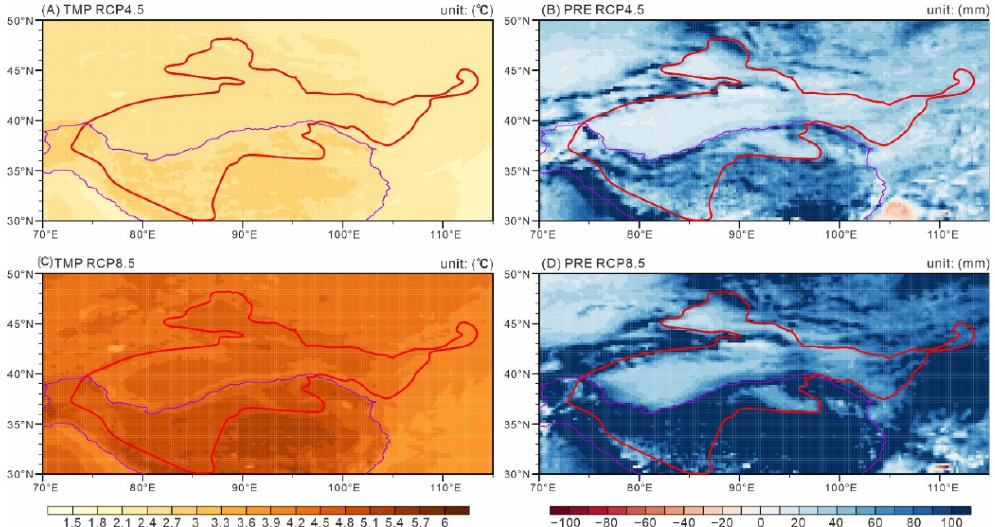
Figure 8. Future changes in ensemble mean temperature ( A , C ) and precipitation ( B , D ) for the period 2069‒2098 in CEA under different scenarios (RCP4.5 and RCP8.5), measured relative to the period 1986‒2005. The red line outlines the CEA region.